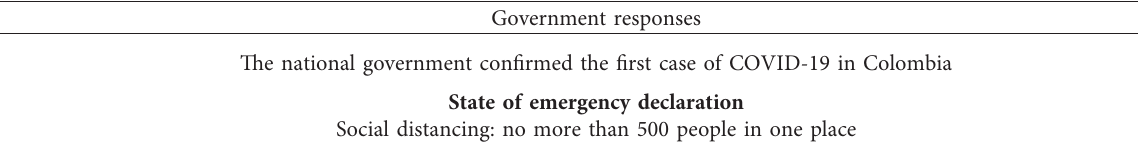
Table 1: Chronology of measures adopted by the Government of Colombia against the spread of COVID-19.